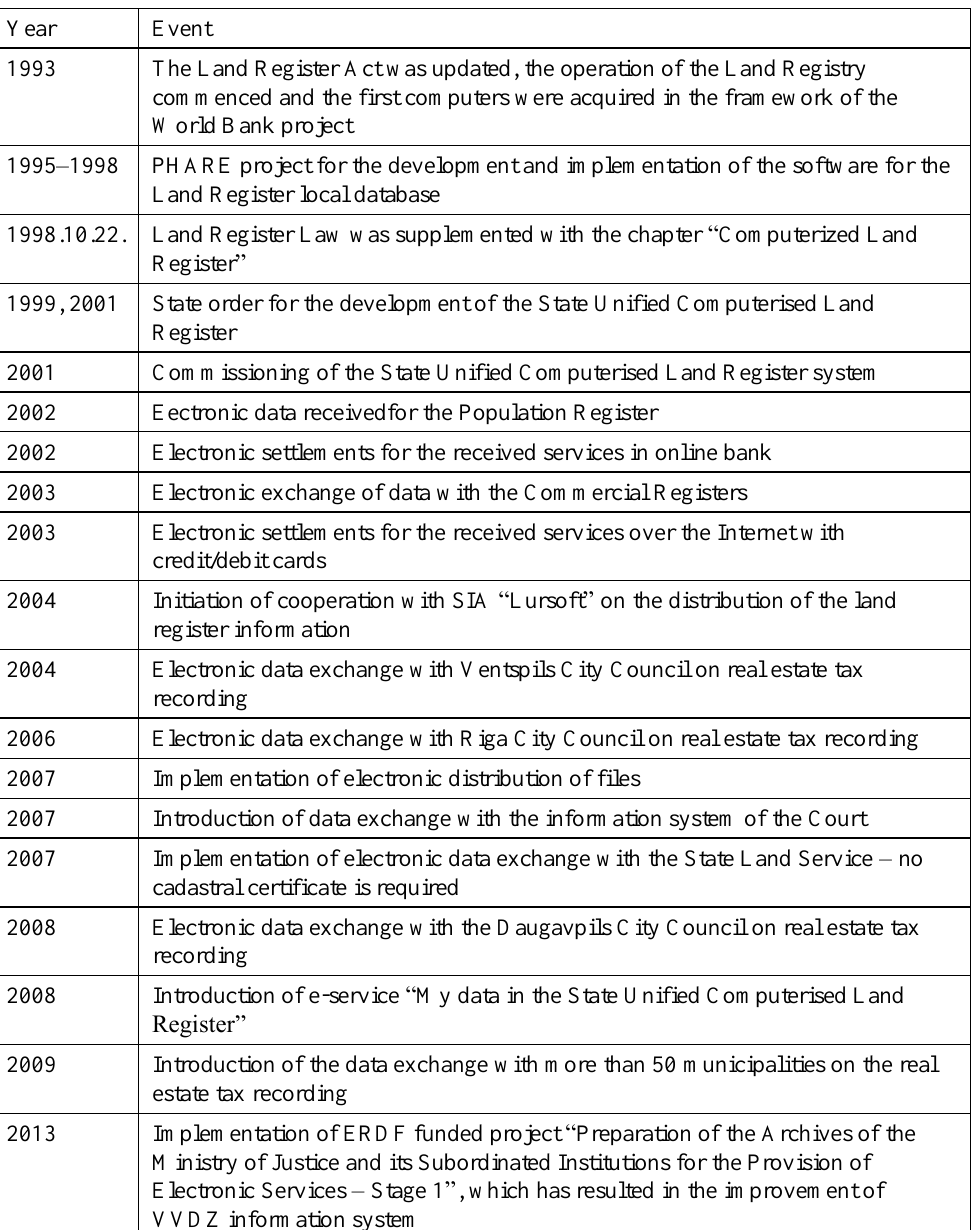
Table 9. The most significant events in the development of the State Unified Computerized Land Register